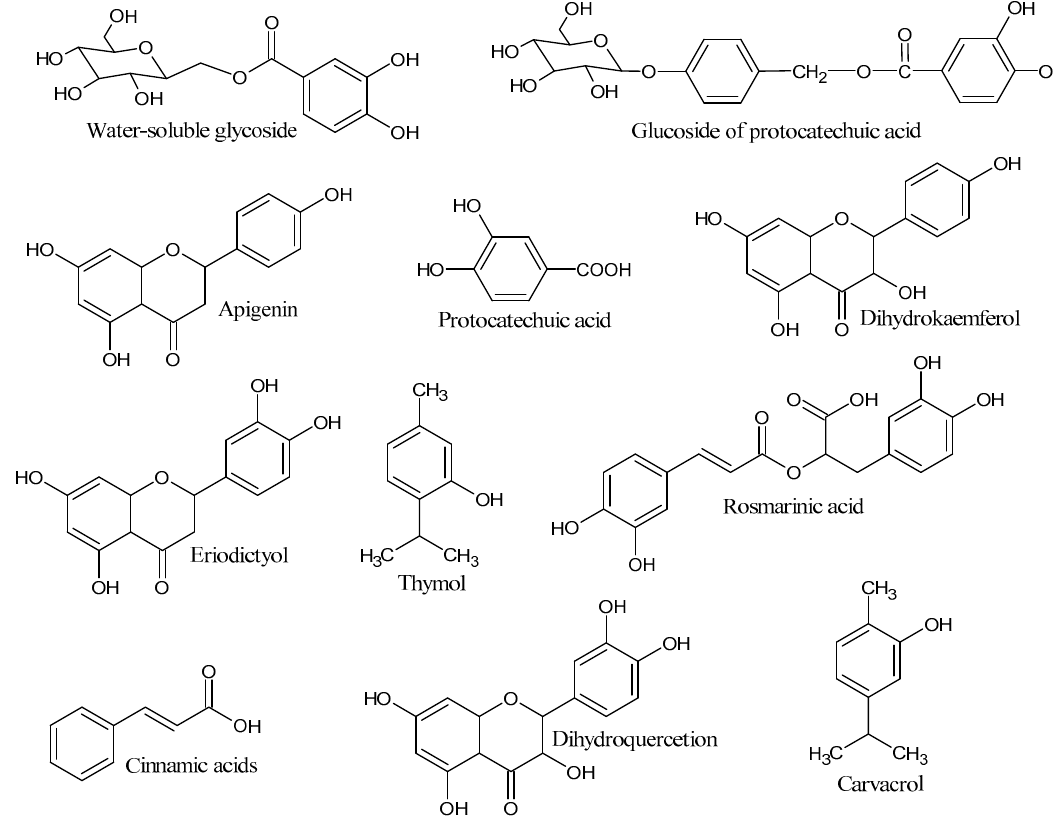
Figure 1. Phytochemicals present in the Origanum vulgare L. Extract.